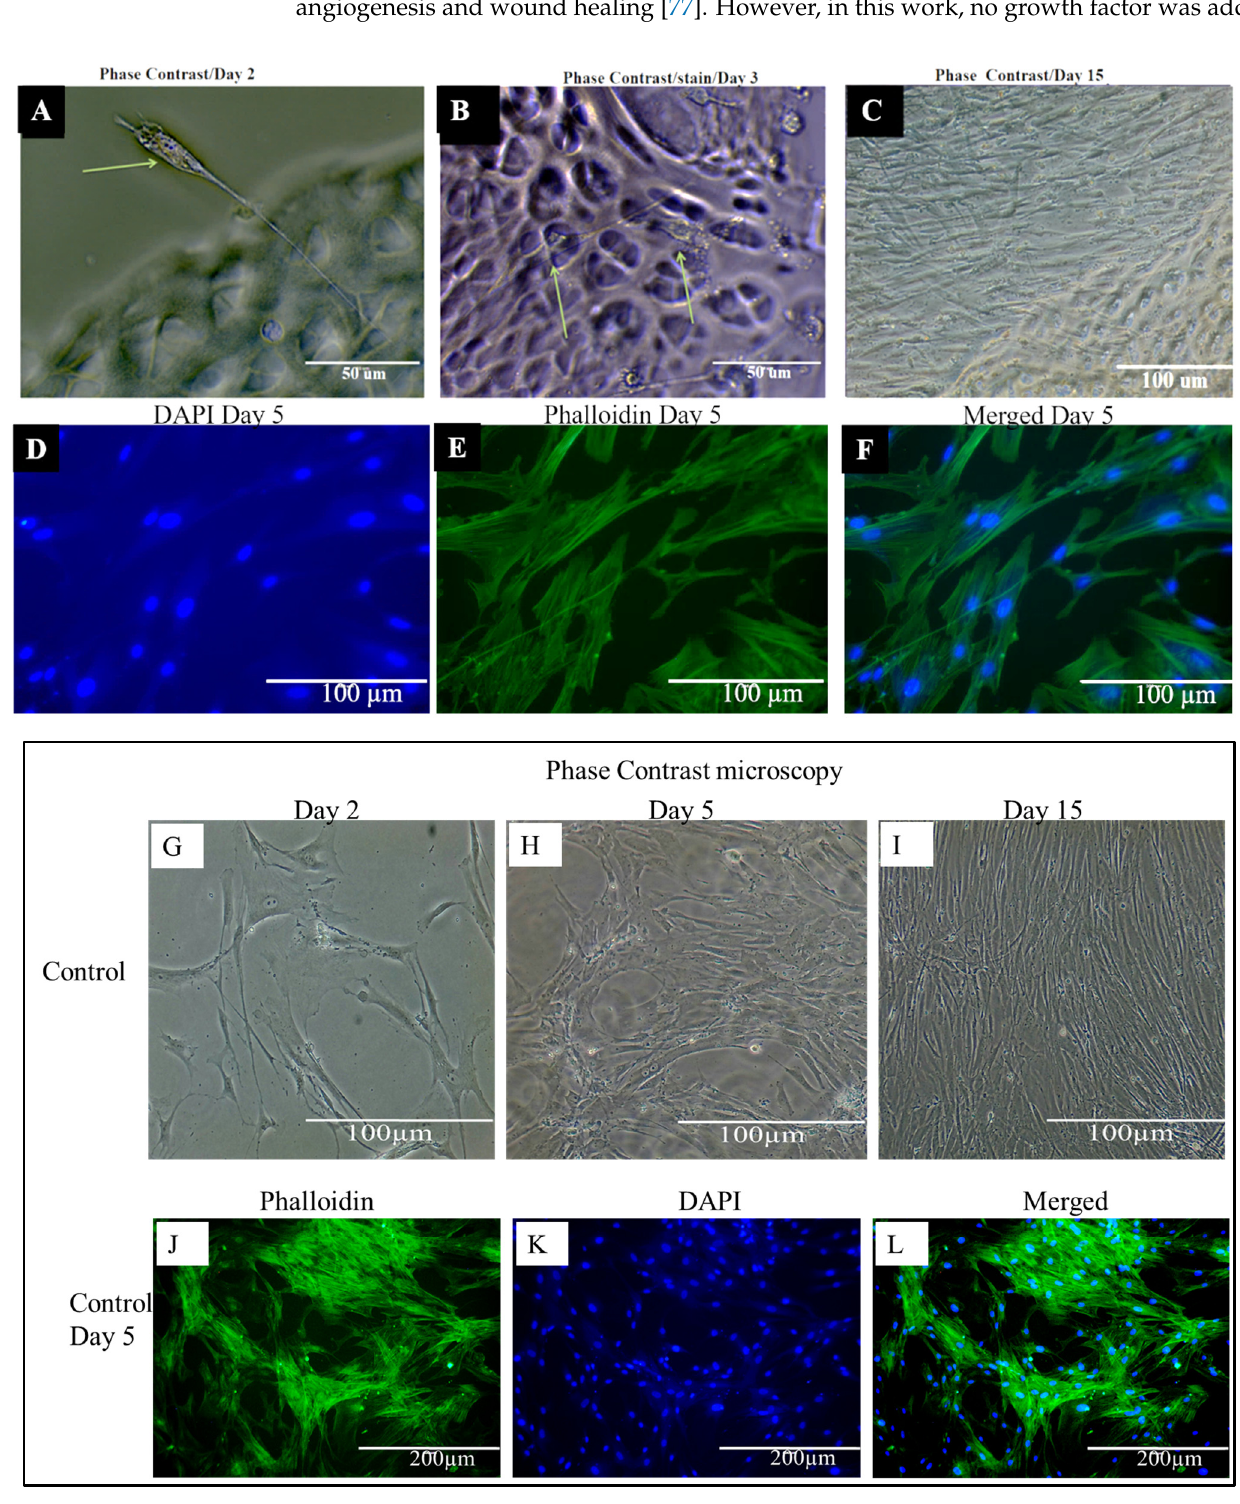
Figure 10. Morphological characteristics of chondrocytes seeded on DACS construct and plate Con- trol. ( A ) Cells photographed after three days of culturing. Scale bar = 50 µm, 100 µm, or 400 µm as indicated on the micrograph. ( B ) Microphotograph of spear-shaped chondrocyte piercing through the DACS taken 50 µm resolution. Chondrocytes body on the plate, while the long pseudopodia stretched into the DACS. The six-well-plated controls did not show a similar phenotypic appear- ance; they were flat, with a large cell body and an extensive number of pseudopodia. ( C ) Complete colonization of scaffold by chondrocytes shown in phase contrast microphotographs day 5. ( D ) Col- onization of scaffold by chondrocytes shown in blue via DAPI staining at day 5.( E ) Colonization of scaffold by chondrocytes shown in green by phalloidin staining at day 5. ( F ) Shows the merging of